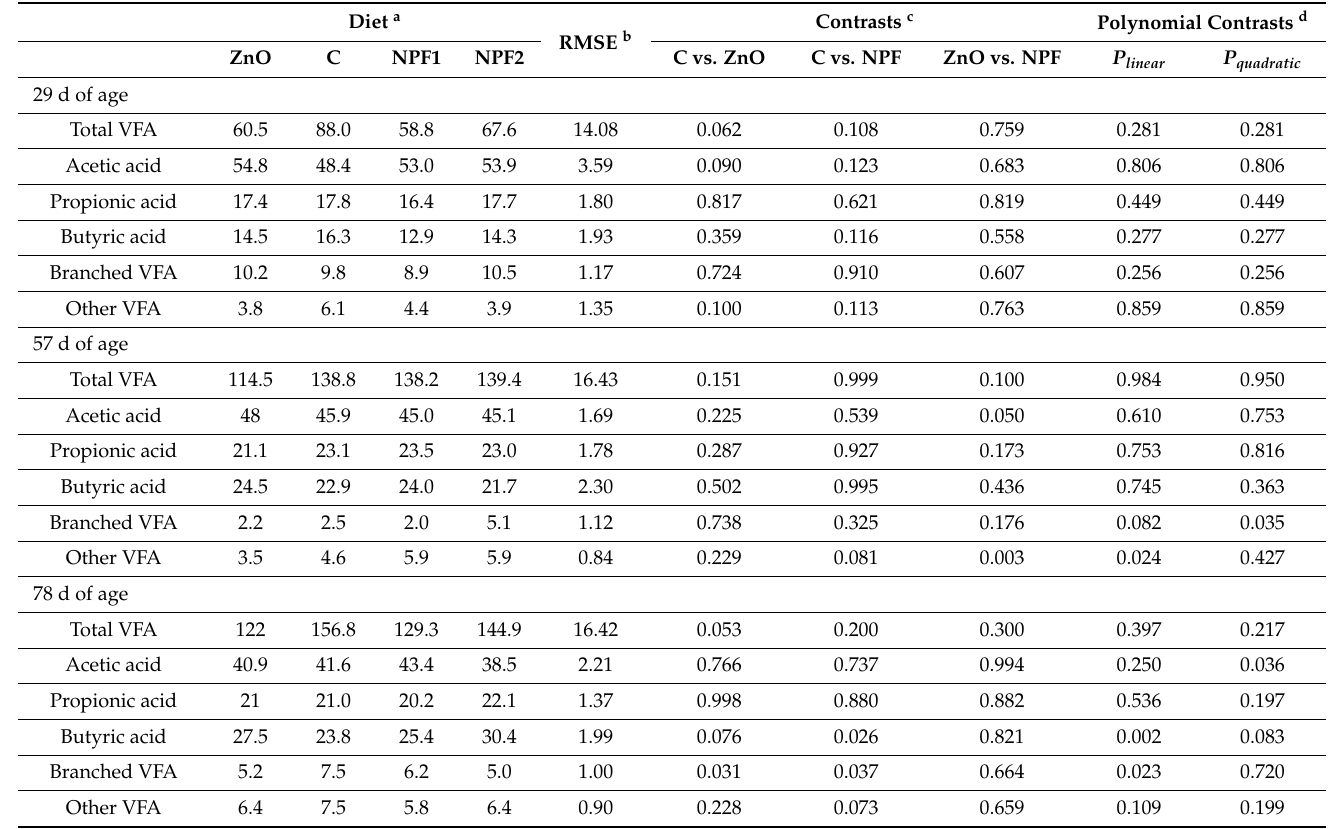
Table 7. Effect of diet on the total volatile fatty acid (VFA, mmol/kg of wet faeces) concentration and molar ratios of VFA (%) in the faecal digesta of piglets at 29, 57 and 78 days of age. Diet a Contrasts RMSE b